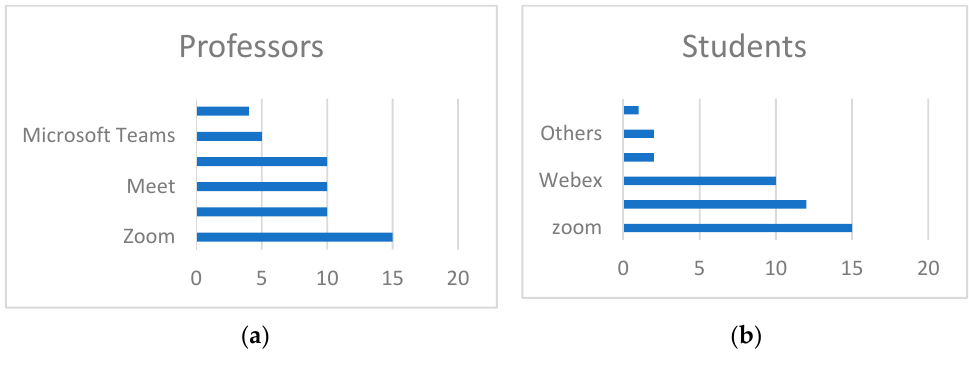
Figure 3. Web platforms usage by teachers ( a ) and students ( b ).